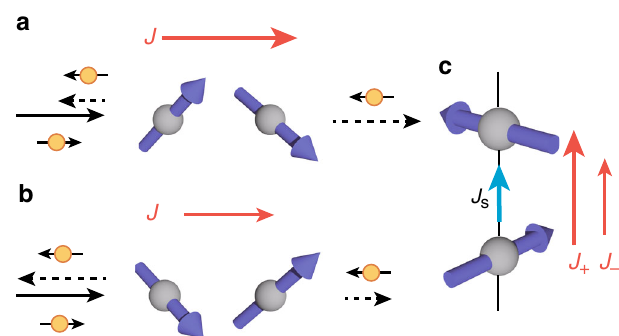
Fig. 1 Nonreciprocal transport by magnetic scattering. a , b Schematic fi gure of magnetic scattering by a two-spin cluster with fi nite vector spin chirality. The backward scattering by the two-spin spin cluster scatters incoming electron with up spin (the electron at the light bottom of the fi gure) depends on the vector spin chirality; less electrons are scattered backward in a compared to b . The weaker backward scattering in a results in a larger current compared to b . c Nonreciprocal spin current for S z in the paramagnetic case. The spin current of electrons J s fl ow along the direction of the supercurrent of magnetic moments because of the difference between the current for up-spin electrons and down-spin